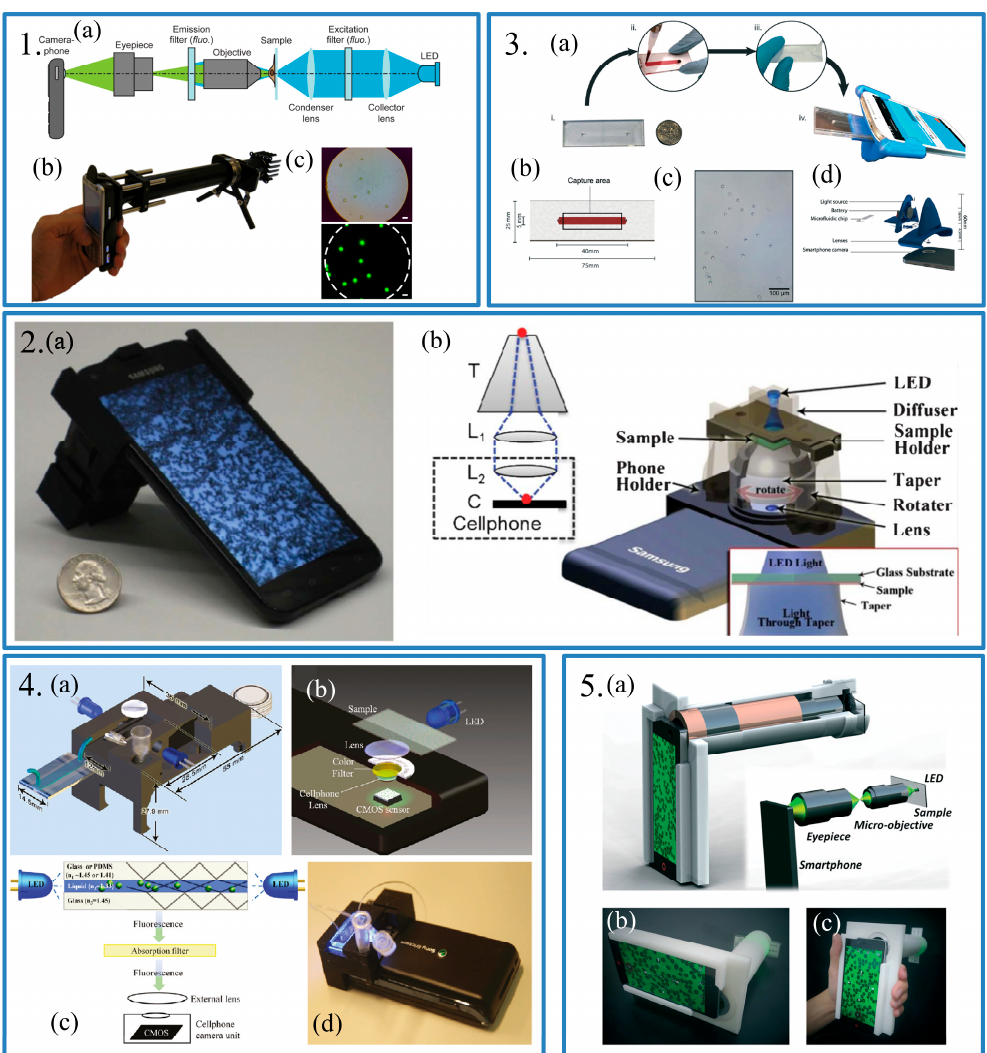
Figure 1. Panel 1: ( a ) Layout of the smartphone-based microscope for fluorescence imaging. The same apparatus was used for bright field imaging, with the filters and LED removed. Components only required for fluorescence imaging were indicated by “fluo”. ( b ) A prototype, with filters and LED installed, capable of fluorescence imaging; ( c ) Bright field image and ( d ) fluorescent image of 6 μ m fluorescent beans. Scales bars are 10 μ m. Reproduced from [20]. Panel 2: ( a ) Photograph of the Contact Scope installed on an Android smartphone; ( b ) Schematic diagram of the smartphone attachment of the Contact Scope. Reproduced from [21]. Panel 3: ( a ) The process flow showing the steps involved in performing the assay; ( b ) The dimensions of the disposable microfluidic chip; ( c ) The image of captured CD4 cells on-chip using the smartphone system; ( d ) The exploded image of the smartphone attachment and the relevant dimensions. Reproduced from [22]. Panel 4: ( a ) The dimensions; ( b ) The schematic diagram and ( c ) The working mechanism of the designed optical attachment for optofluidic fluorescence imaging cytometer on a smartphone; ( d ) The photograph of the optofluidic fluorescent imaging cytometer on a smartphone. Reproduced from [23]. Panel 5: ( a ) Design and ( b ) optical system of the smartphone based hand-held quantitative phase microscope; ( c ) Integrated smartphone based hand held quantitative phase microscope with its 3-D printed shell. Reproduced from